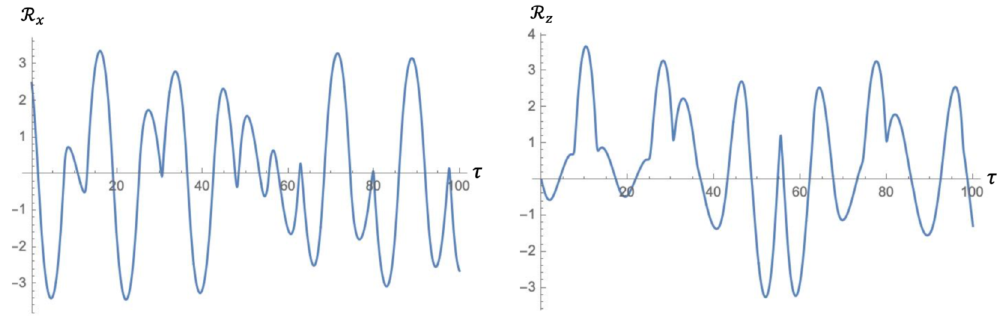
Figure 4 . The motion in the R x - R z plane over longer time